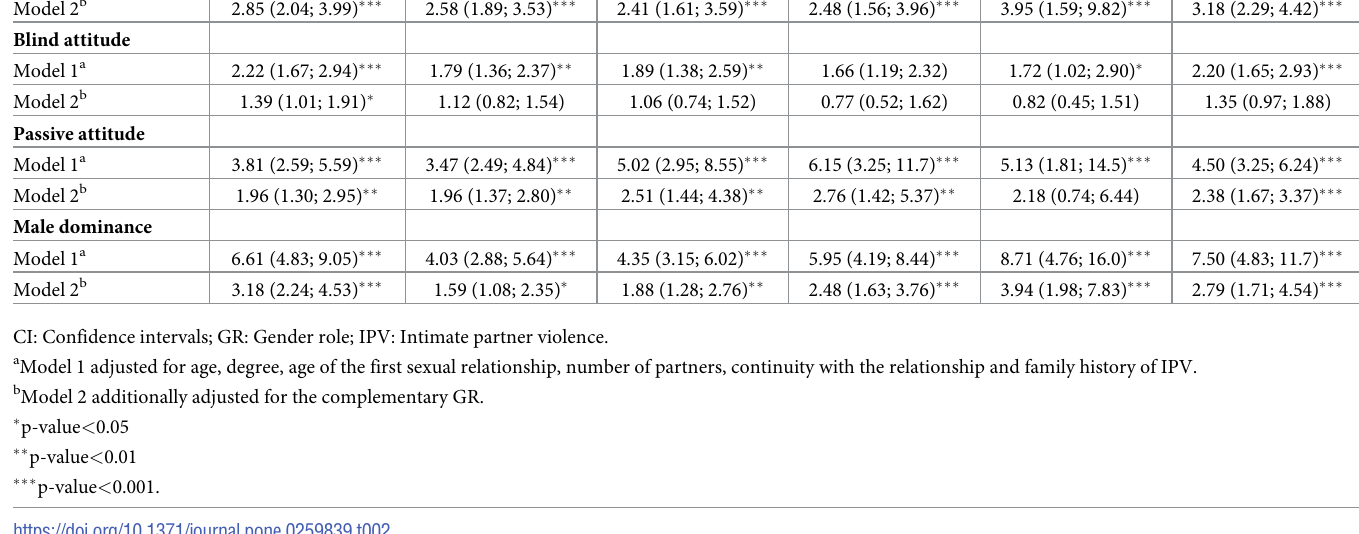
Table 2. Adjusted odds ratios (95% CI) for the association between GRs and IPV indicators (n = 1,005). Coercion